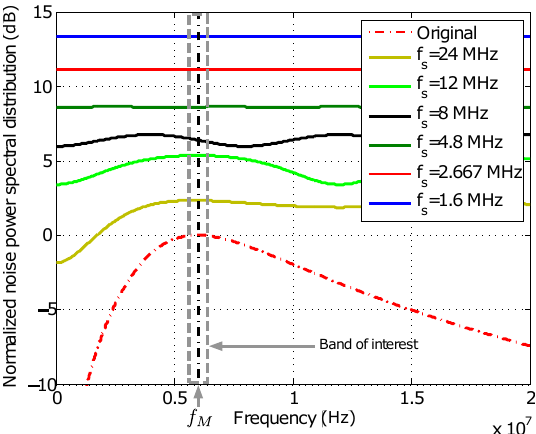
Figure 3. Computation of the normalized noise power spectral distribution after digitization for different sampling frequencies ( f s )